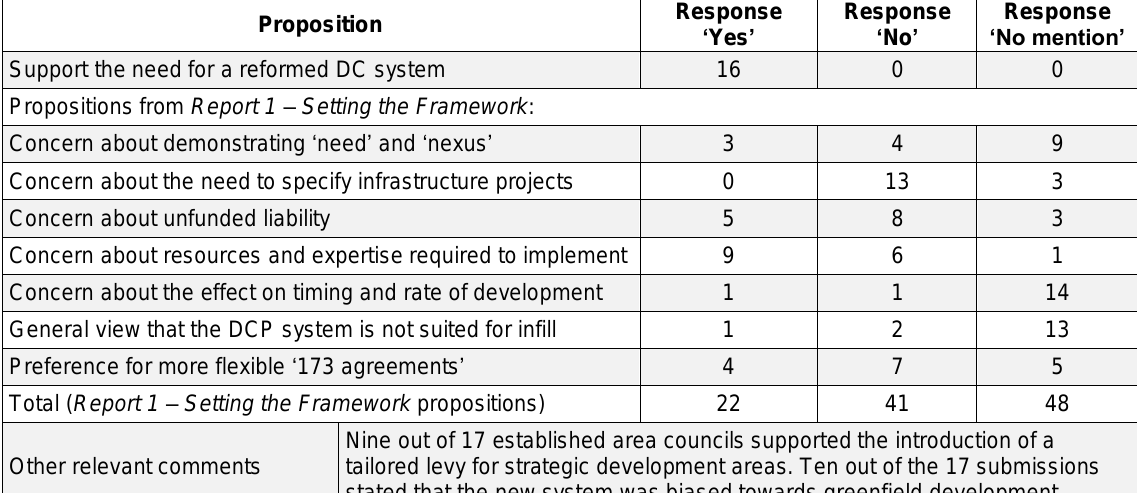
Table 1: Summary of document analysis findings for established area councils